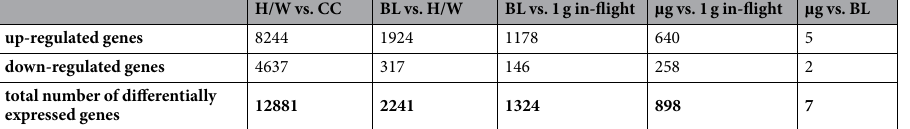
Table 6. Differentially expressed annotated genes in T cells during the TEXUS-51 mission. Number of annotated genes that were significantly differentially expressed in the respective comparison. CC: cell culture control samples, H/W: hardware 1 g ground control samples, BL: baseline control samples representing the influence of the rocket launch, µ g: microgravity samples. Fold change ± 1.3, p < 0.05.